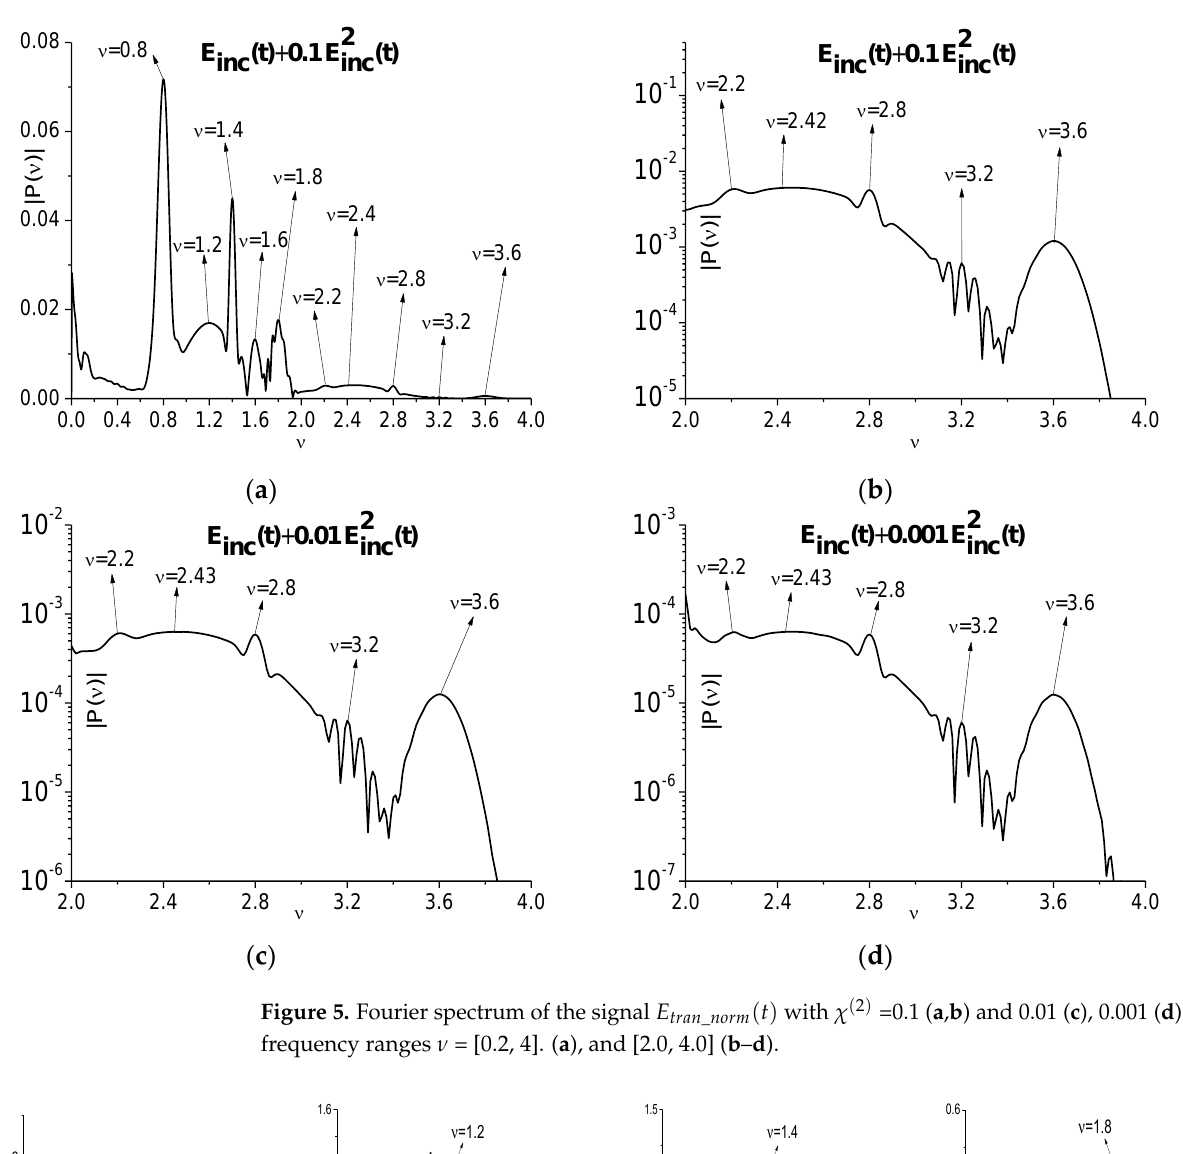
Figure 6. Evolution of the spectral amplitudes modulus at the basic and doubled frequencies ν = (0.8, 1.6) ( a ), (1.2, 2.4) ( b ), (1.4, 1.8) ( c ), (1.8, 3.6) ( d ) with χ signal E inc ( t ) , red lined—to the signal E tran _ norm ( t )